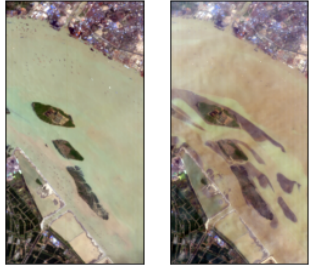
Figure 3. RGB rendering of the River dataset